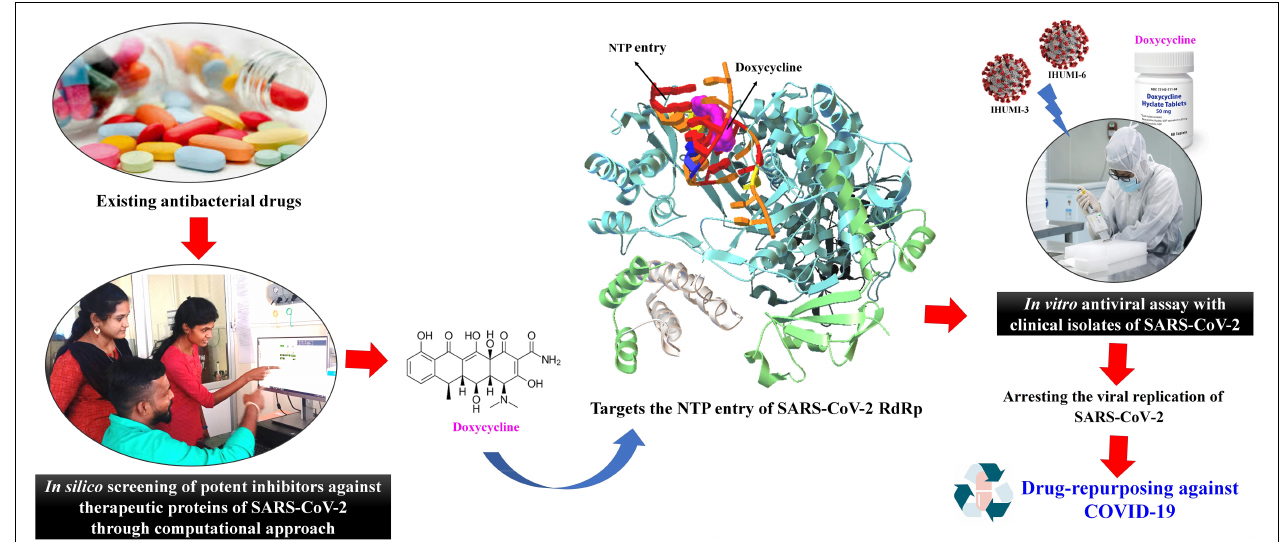
FIGURE 1 | Graphical representation of the present study for the drug-repurposing of doxycycline against